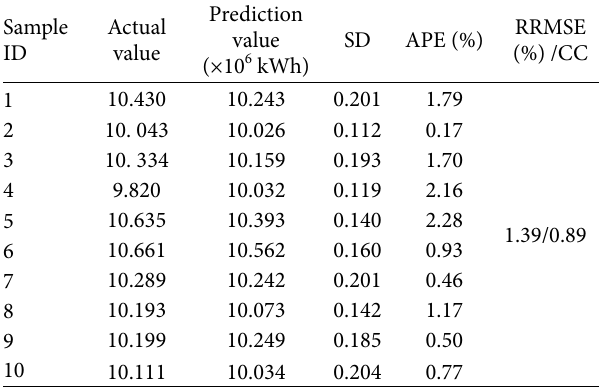
Figure 6: The predicted results of the 10th test sample. Table 5: Prediction accuracy of the SVR model.